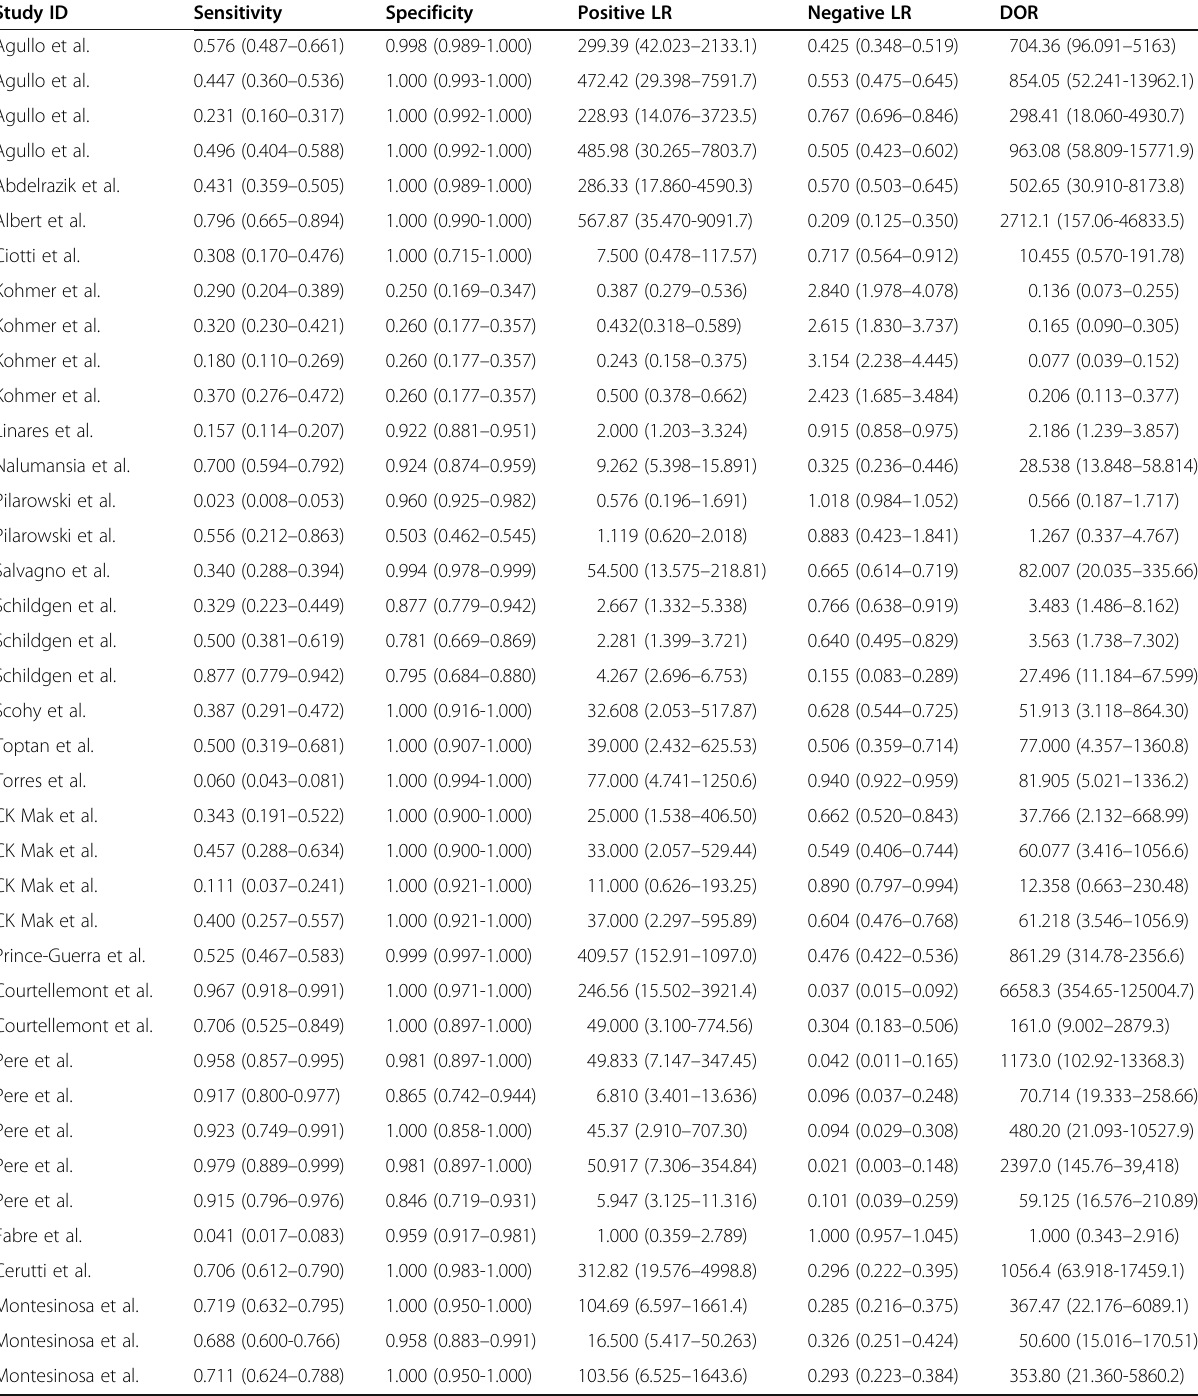
Table 2 Pooled analysis of sensitivity and specificity of included studies with 95% confidence